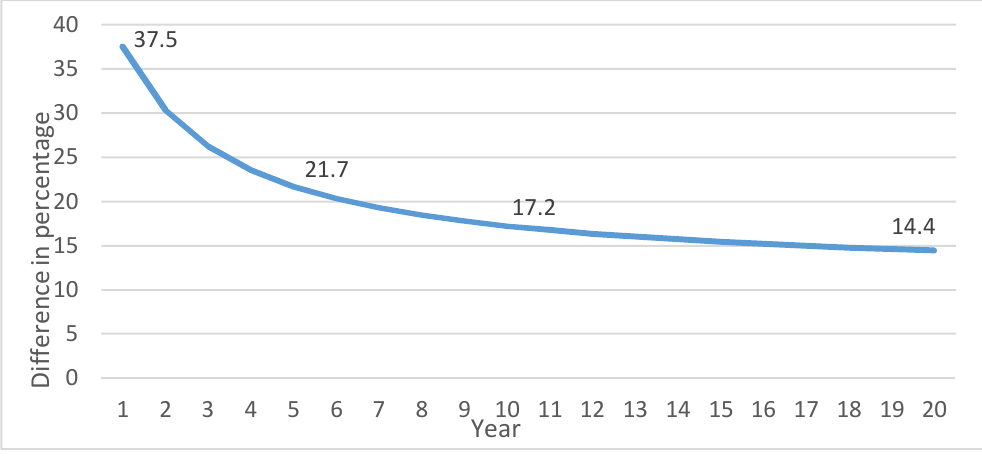
Figure 7. Percentage total cost difference between the two systems during 20 years.